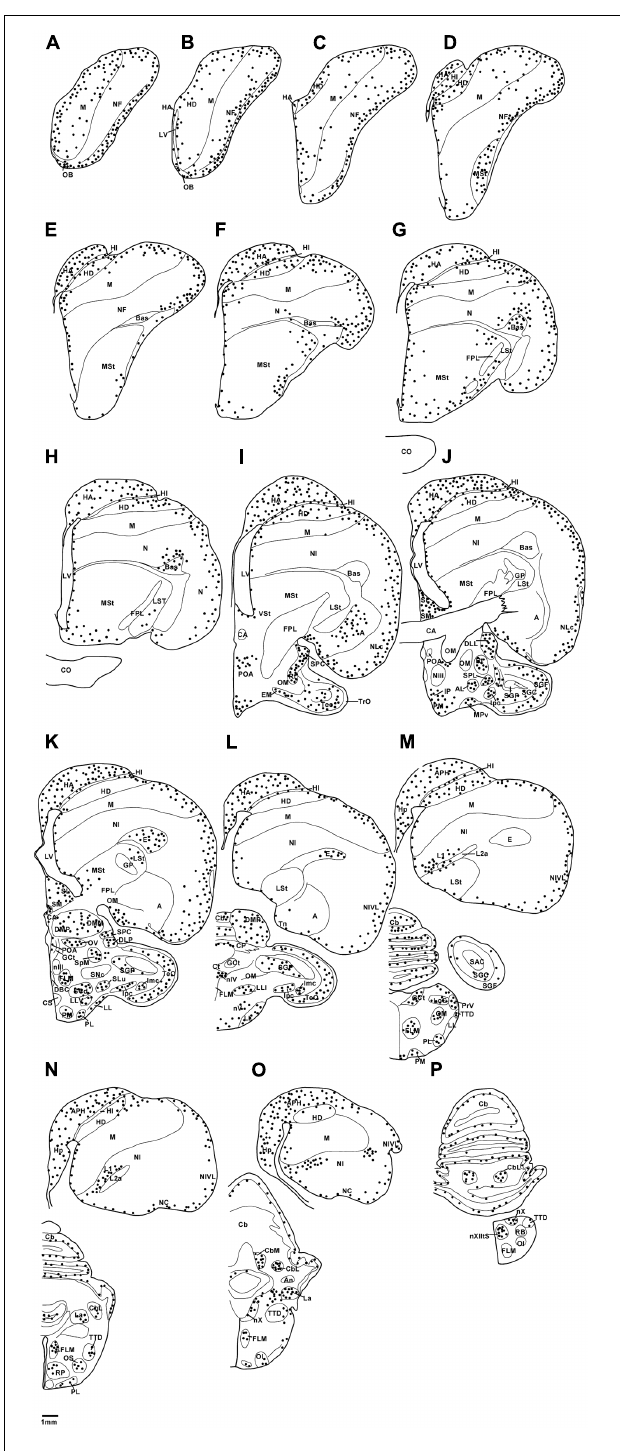
FIGURE 1 | Diagrammatic reconstructions of a series of evenly spaced coronal sections through one half of the brain of the African grey Parrot illustrating the distribution of PCNA-immunoreactive cells. A single black dot indicates a single cell. Drawing (A) represent the most rostral section, (P) the most caudal, and each drawing is approximately 1,500 µ m apart. For example distance between A,B is 1,500 µ m. The same applies for B–P . See list for